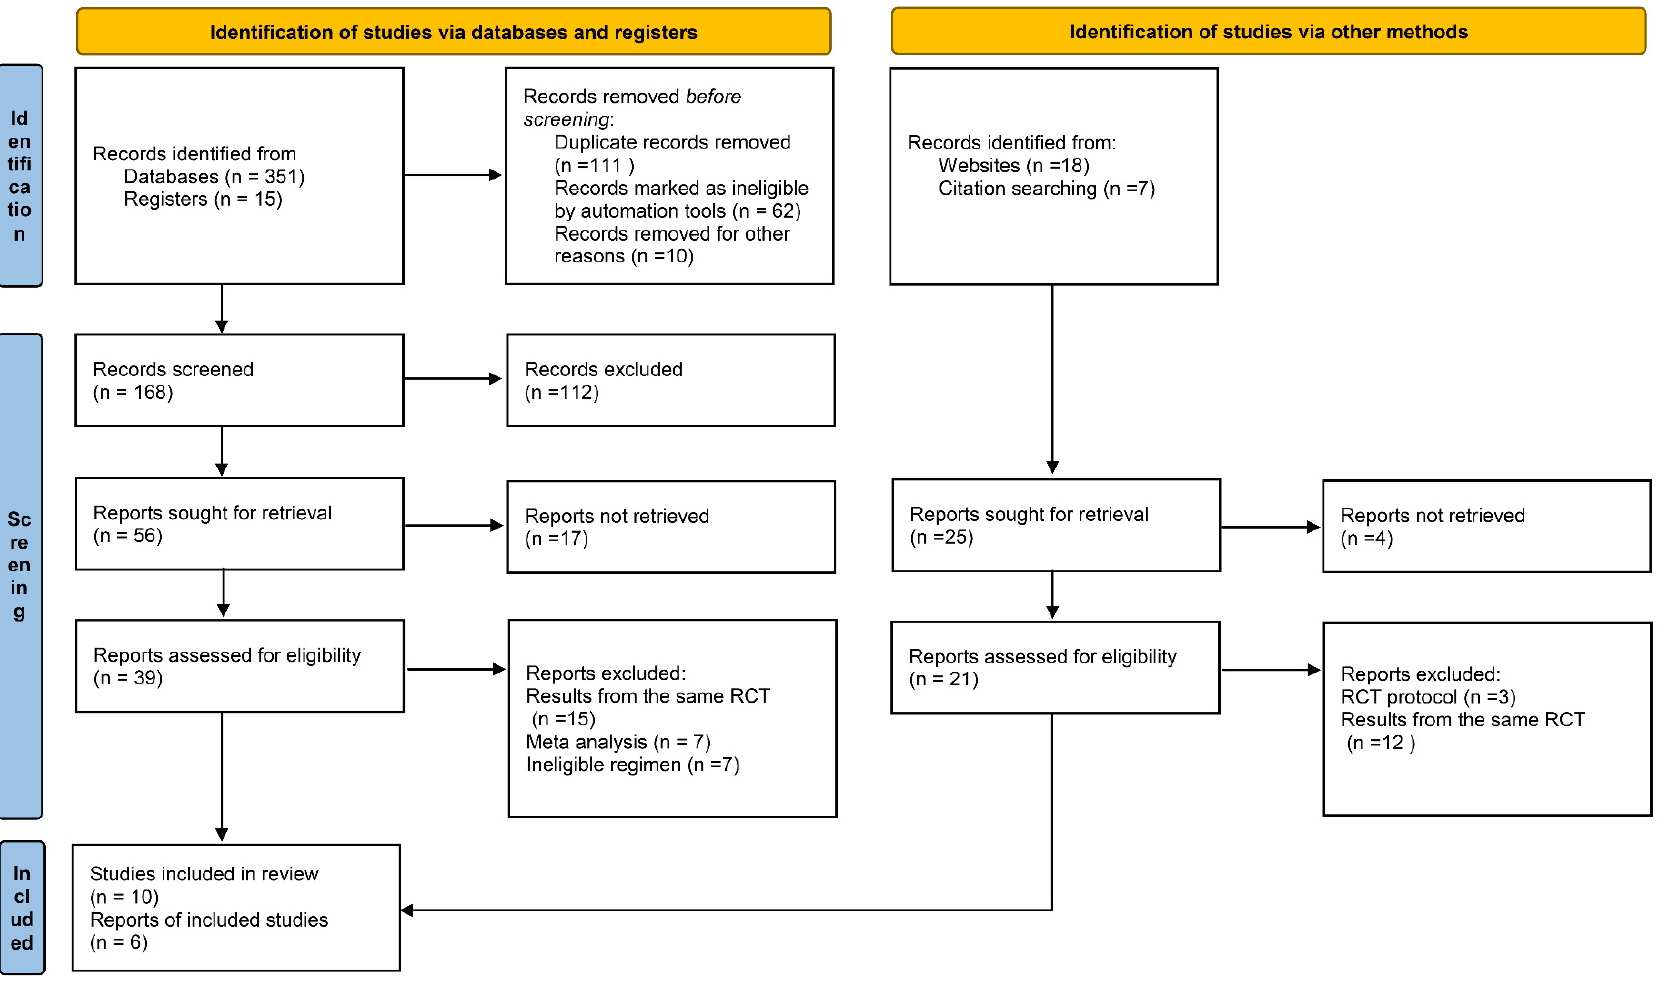
Figure 1. PRISMA 2020 flow diagram for new systematic reviews.